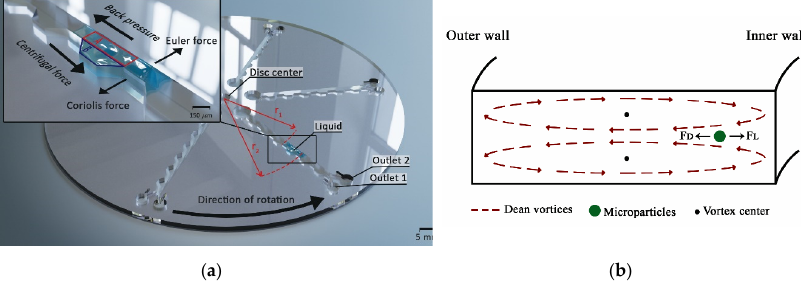
Figure 4. ( a ) 3D representation of the design with an illustration of forces affecting a fluid element passing through the channel. The channel size is exaggerated for demonstration purposes. ( b ) A cross-section in a rectangular spiral microchannel showing the direction of Dean vortices and the forces affecting microparticles flowing in that channel.